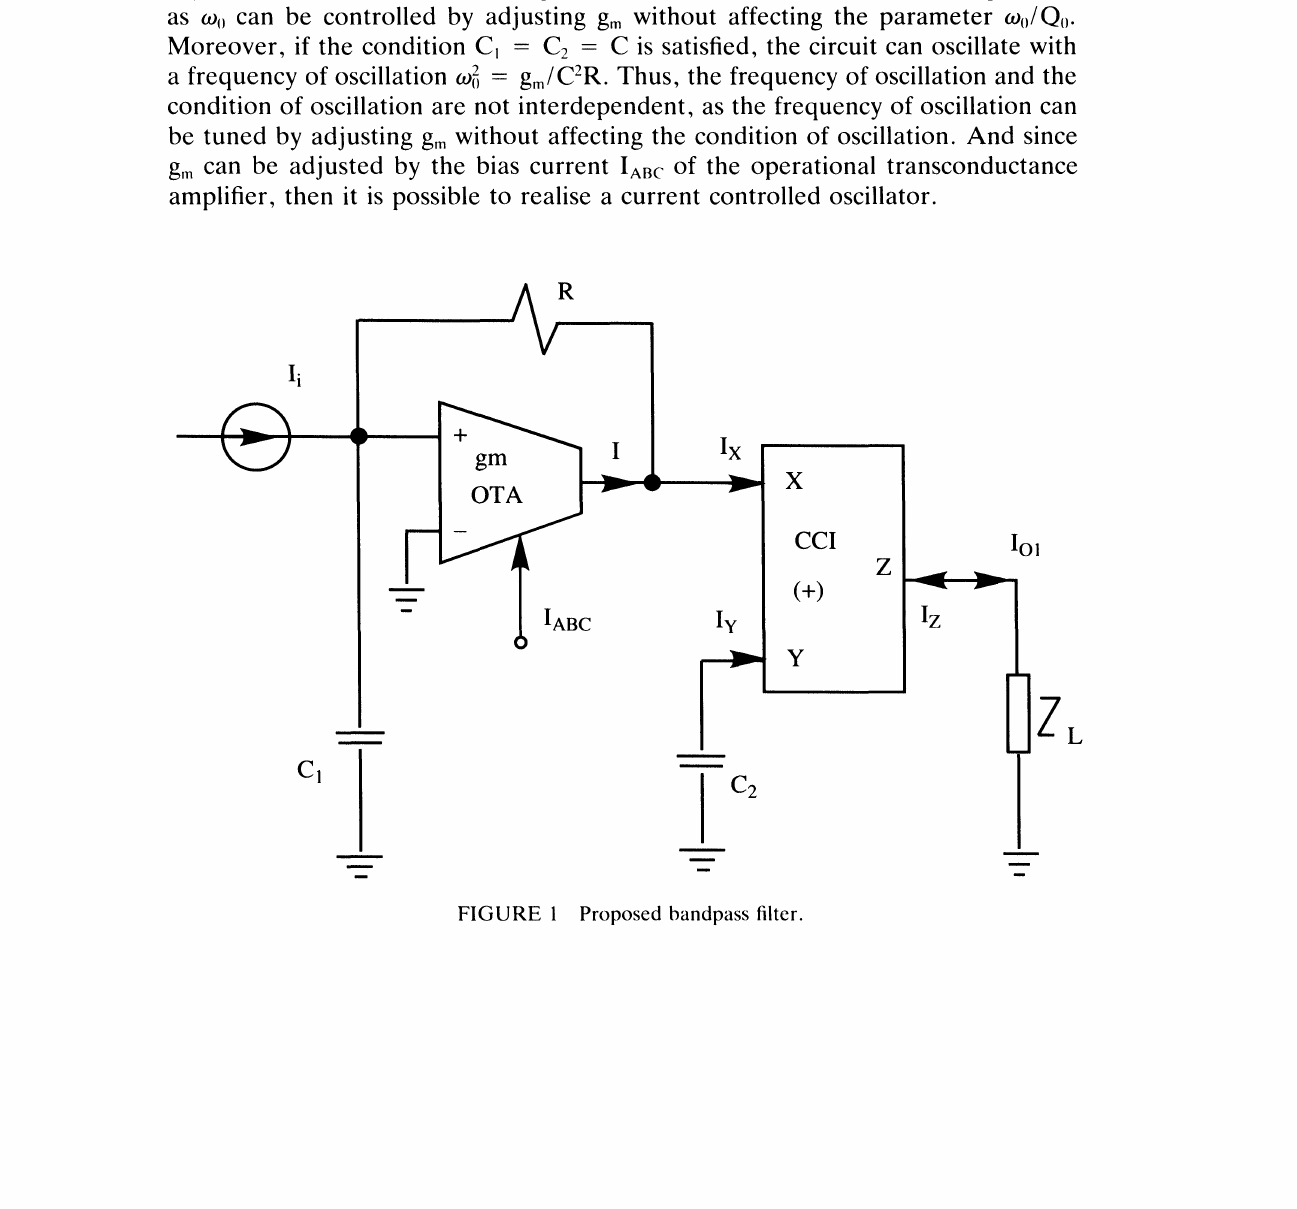
FIGURE Proposed bandpass